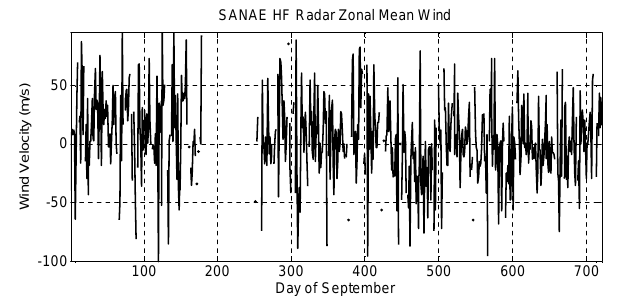
Fig. 2. Hourly averaged zonal mean wind as observed by the SANAE HF radar during September 2002.